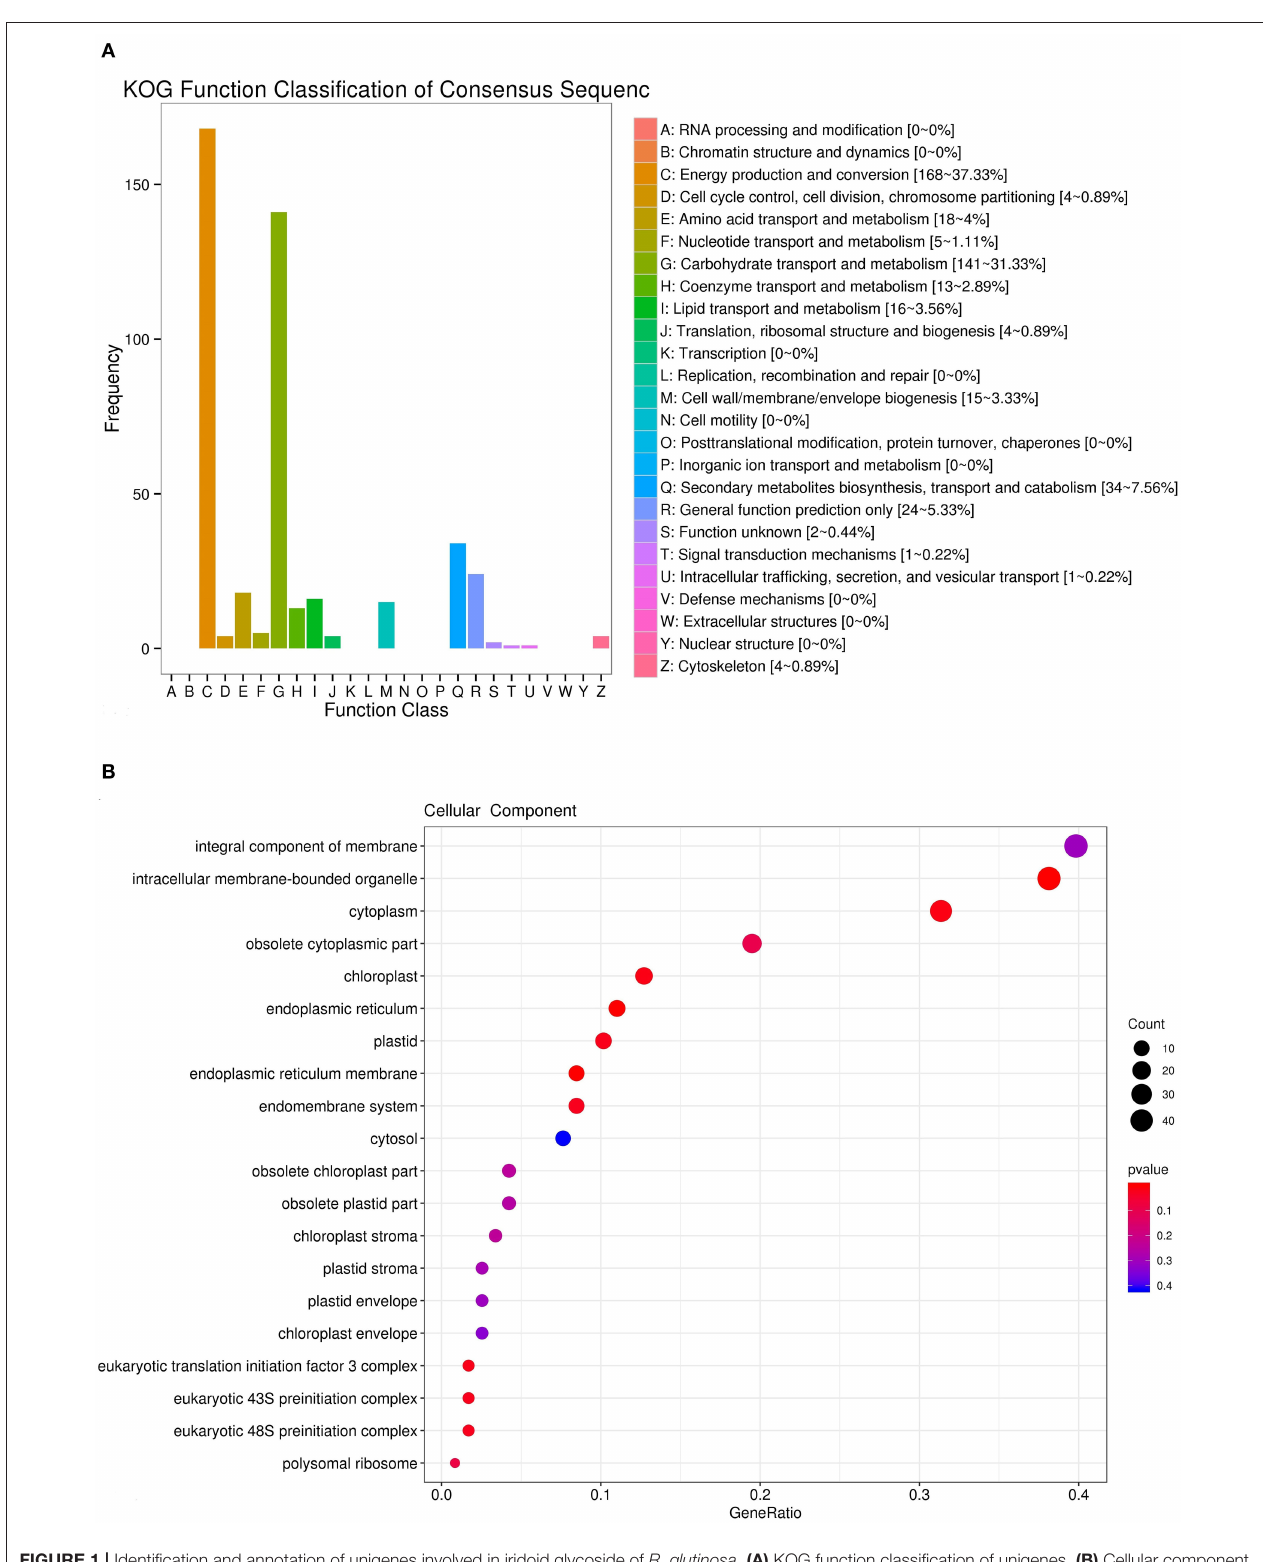
FIGURE 1 | Identification and annotation of unigenes involved in iridoid glycoside of R. glutinosa . (A) KOG function classification of unigenes. (B) Cellular component enrichment of unigenes.